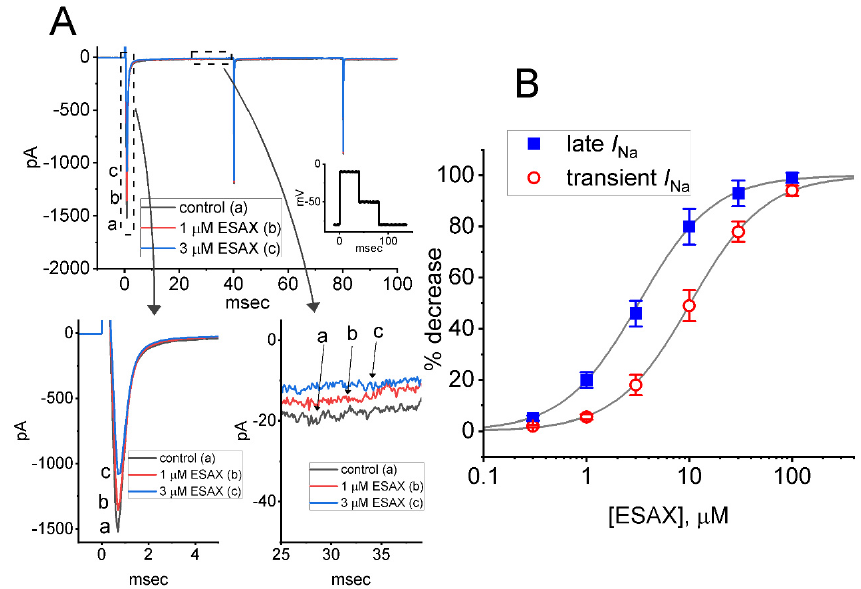
Figure 1. Effect of esaxerenone (ESAX) on voltage-gated Na + current ( I Na ) measured from pituitary tumor (GH 3 ) cells. This set of experiments was undertaken in cells bathed in Ca 2+ -free, Tyrode’s solution containing 10 mM TEA, and we filled up the electrode by using Cs + -containing solution. ( A ) Representative I Na traces obtained in (a) the control situation (i.e., ESAX was not present) and during cell exposure to 1 μ M ESAX (b) or 3 μ M ESAX (c). The voltage pulse protocol applied is shown in Inset. The lower panels in ( A ) show the expanded records from each dashed box. ( B ) Concentration-dependent relationship of ESAX on transient (or peak) ( ○ ) and late ( █ ) component of I Na evoked by abrupt membrane depolarization (mean ± SEM; n = 8 for each point). Each smooth line indicates the goodness-of-fit to the Hill equation, as described in Materials and Methods.